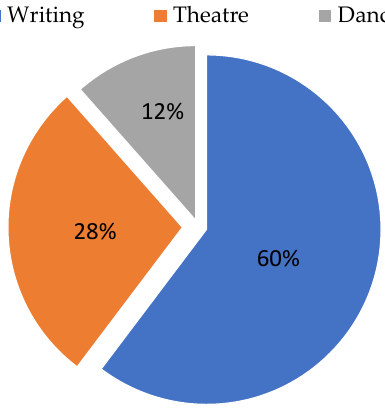
Figure 1. Student Choice